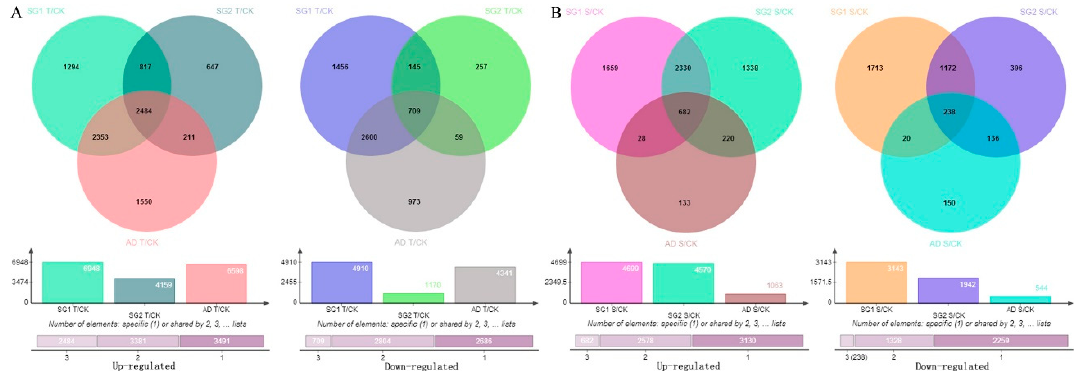
Figure 3. Venn diagram showing the numbers of differentially expressed genes among the Al-tolerant and Al-sensitive varieties. ( A ). Comparison among three Al-tolerant varieties; ( B ). Comparison among three Al-sensitive varieties. T, S, and CK represents Al-tolerant varieties under Al toxicity after 24 hr, Al-sensitive varieties under Al toxicity after 24 hr, and without Al treatment, respectively.